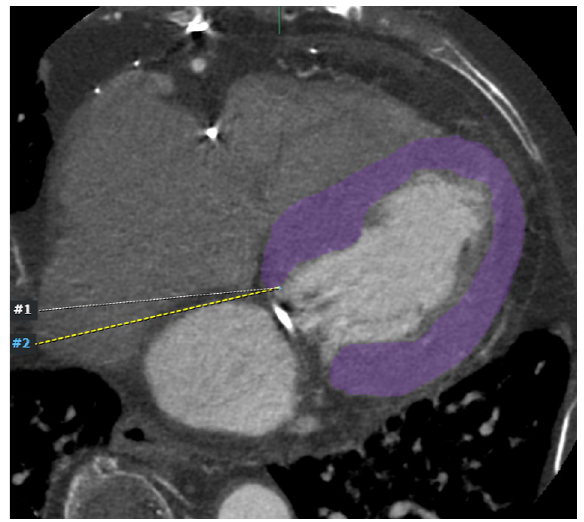
Figure 4. Axial cardiac CT image of a 77-year-old female patient. The myocardium (purple color) is segmented by excluding the LV blood pool and trabeculae to improve reproducibility for delineating the endocardial border. CT, computed tomography; LV, left ventricular.